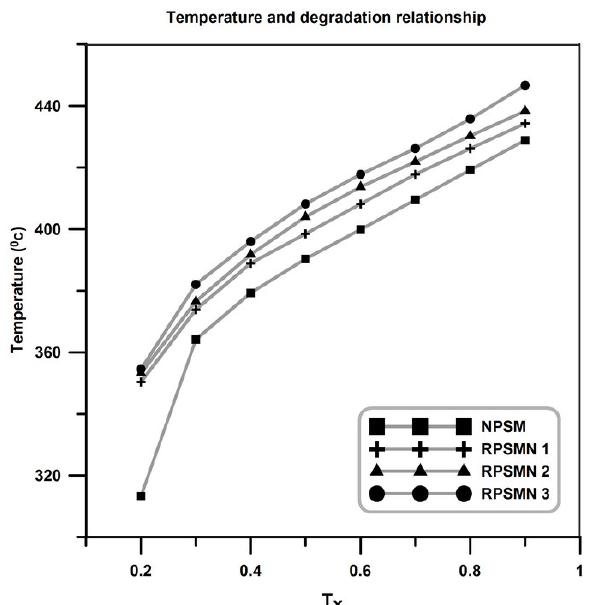
Figure 10: Graphical illustration of temperature and degradation relationship